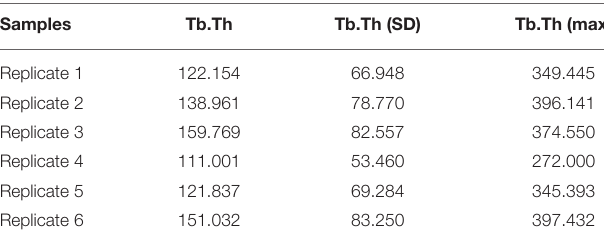
TABLE 6 | Tb.Th measurement for the biological replicates of the test sample (in µ